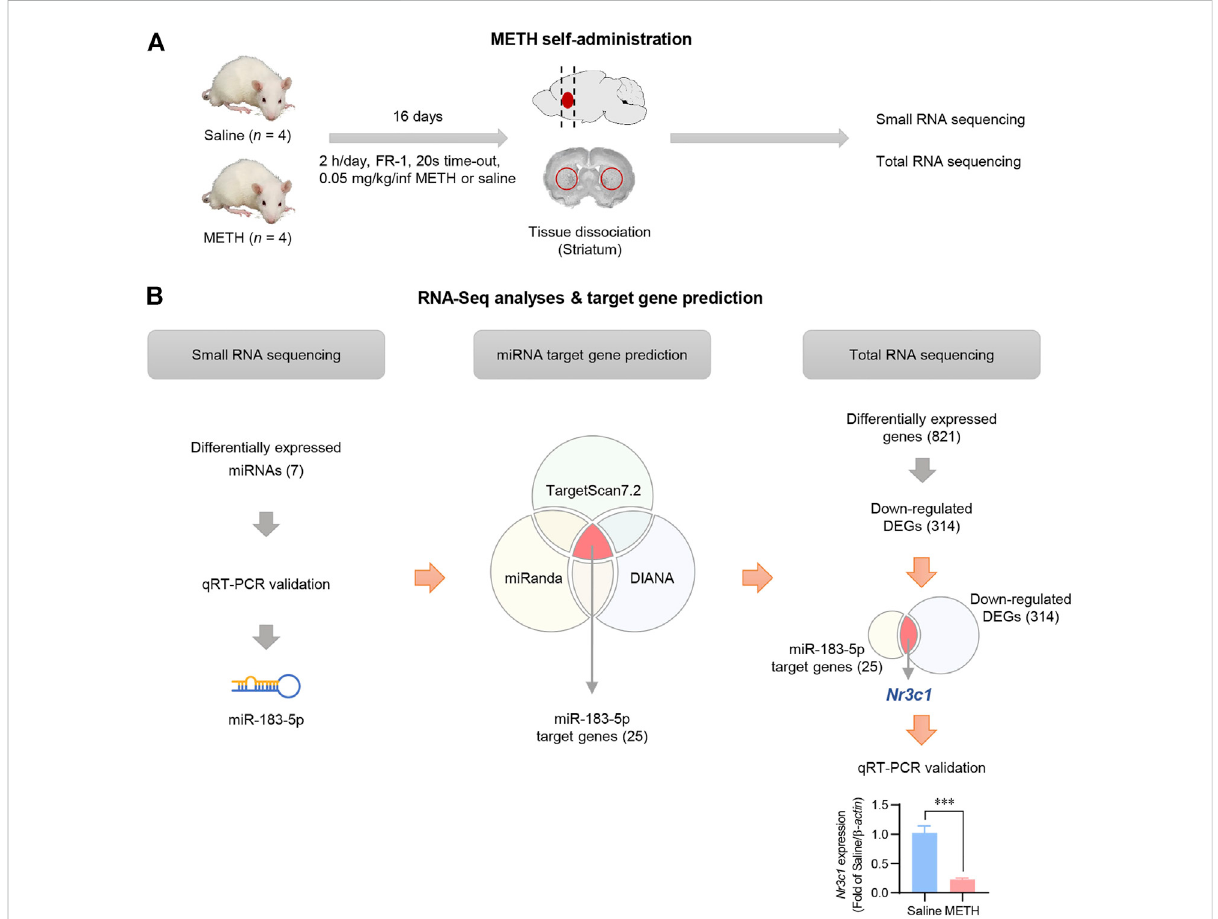
FIGURE 1 Identi fi cation of miRNA transcripts in METH self-administered rats. (A) Flowchart showing an overview of the experimental procedure. (B) The overall work fl ow for identi fi cation of miRNA and its target gene. Nr3c1 expression level in the striatum was analyzed by qRT-PCR and normalized to β -actin level. Data are presented as the fold change relative to the saline group. Statistical analyses were performed using the Student ’ s t -test. Error bars represent mean ± SEM ( n = 4). *** p <